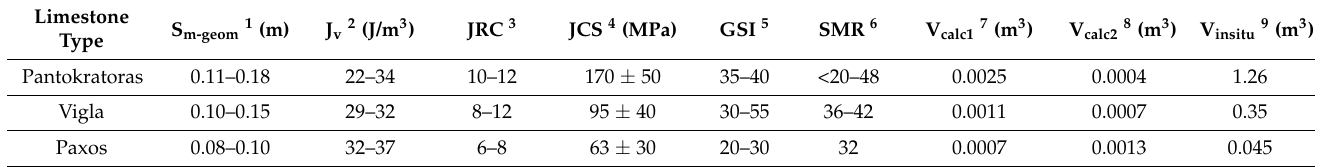
Table 1. Typical range of rock mass characterisation and classification of the studied